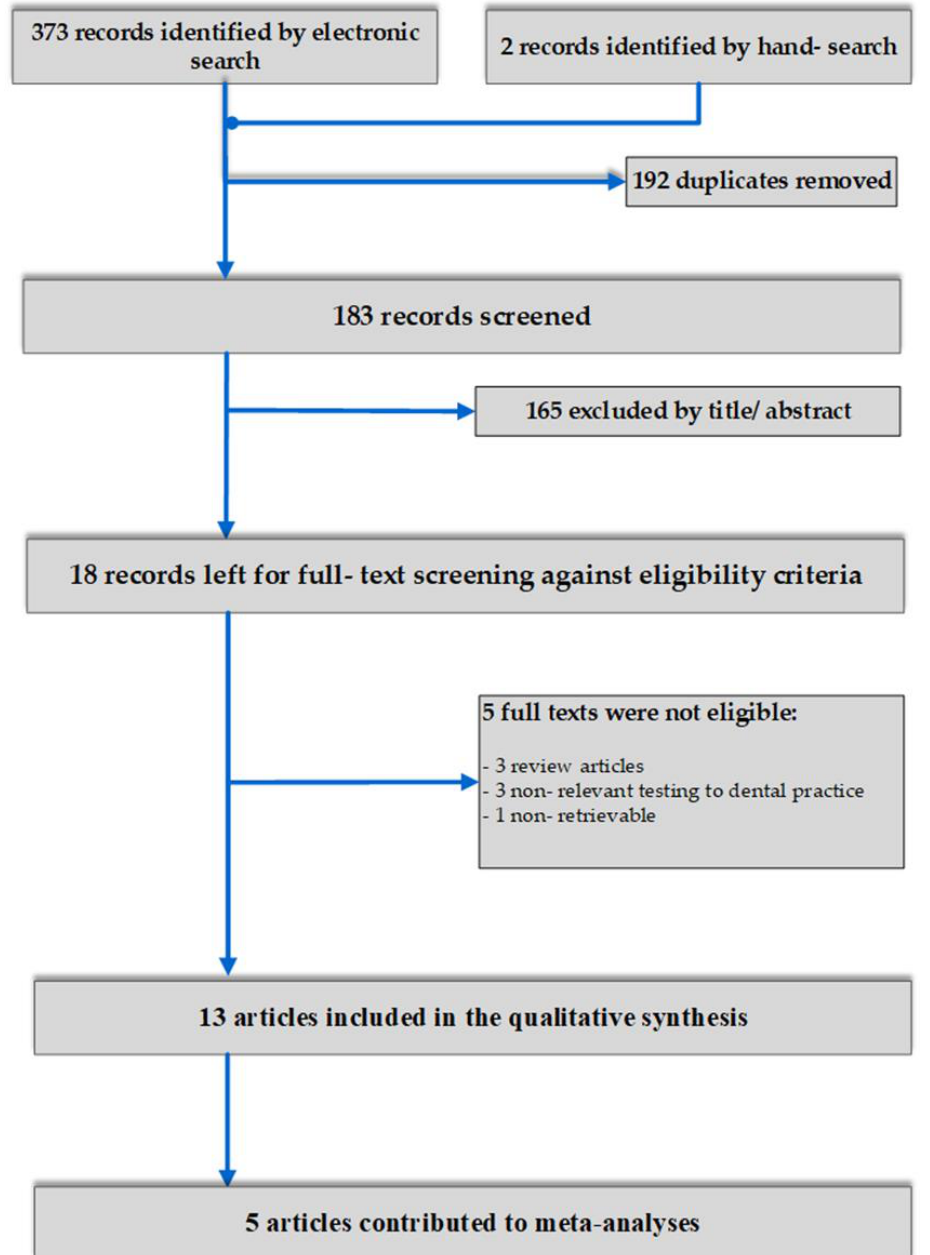
Figure 1. Flow-diagram of study selection.